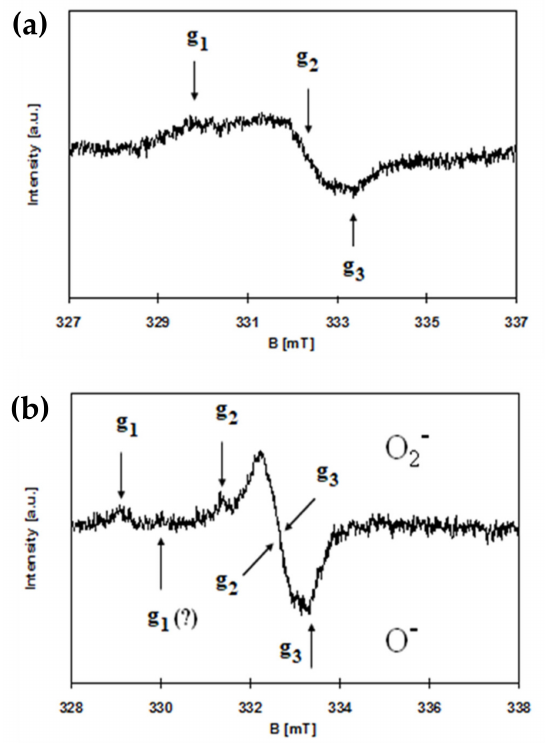
Figure 8. EPR spectra of PCL + 20( 1 ) ( a ) and PCL + 20( 2 ) ( b